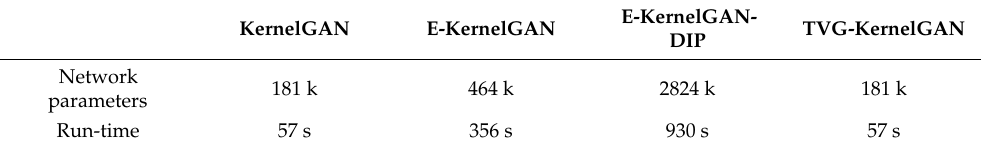
Table 3. Run-time for scale factor of × 2 and the network parameters of KernelGAN